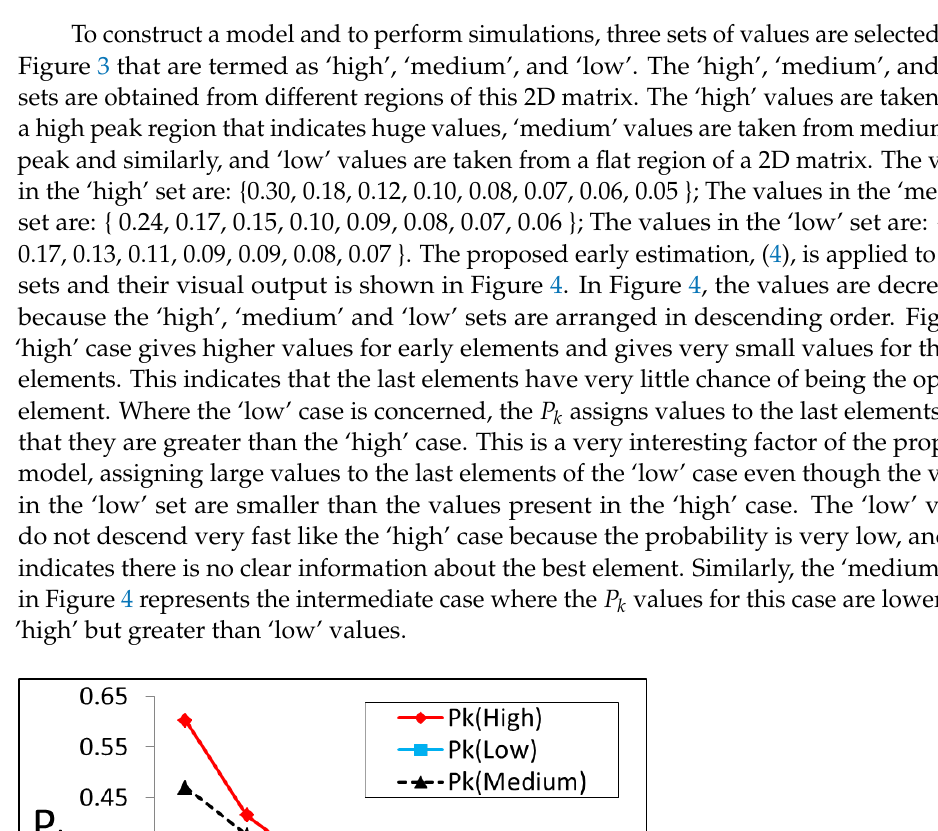
Figure 3. Probabilities of intra mode based on its neighboring blocks.